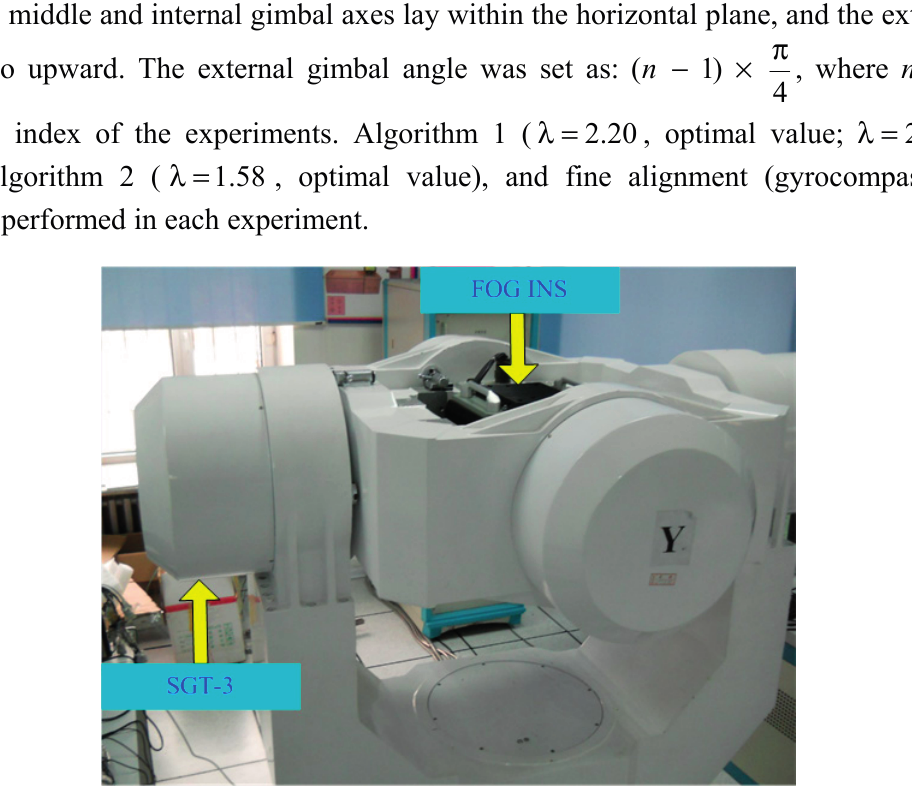
Figure 9. The lab experiment